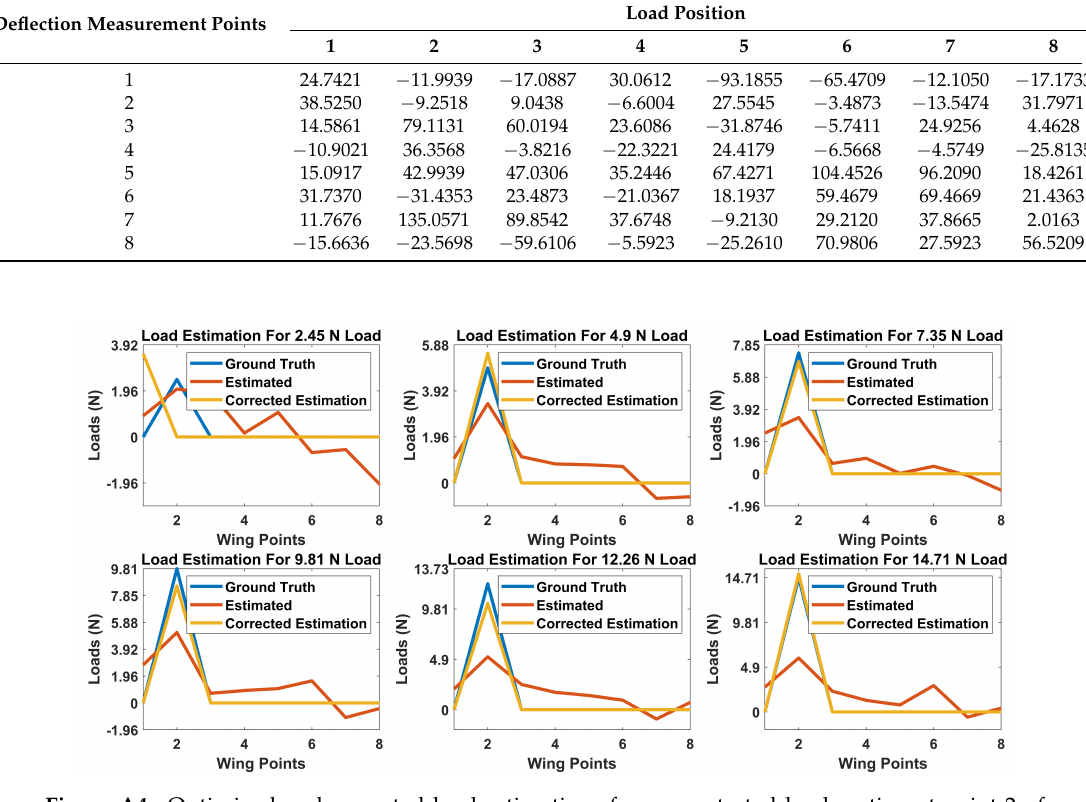
Figure A4. Optimized and corrected load estimations for concentrated loads acting at point 2 of the wing.